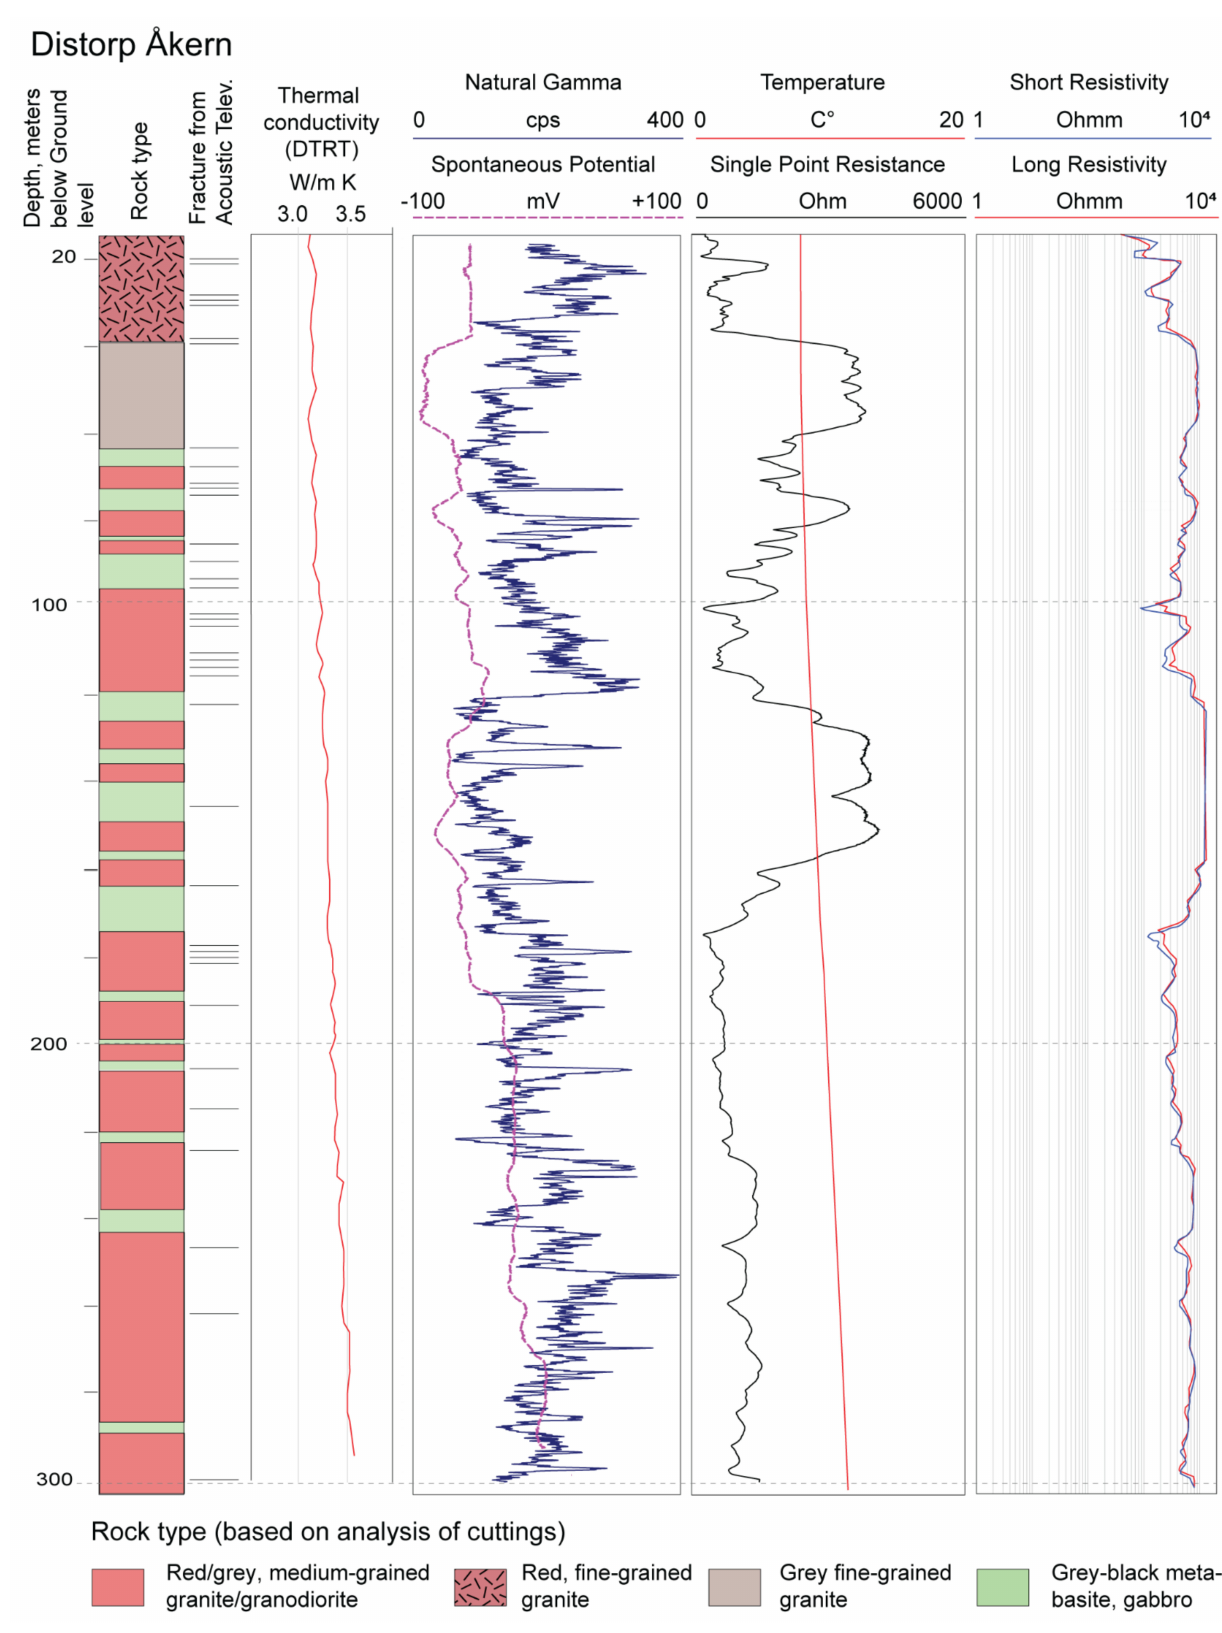
Figure 5. Composite log of the 300 m deep Distorp Åkern